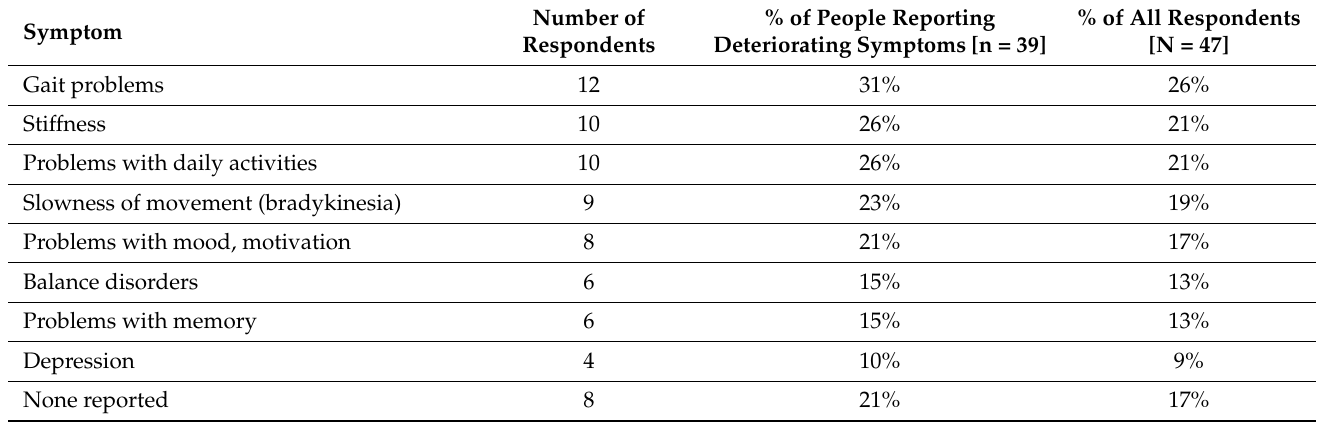
Table 3. The deterioration of symptoms in the pandemic period reported by PD